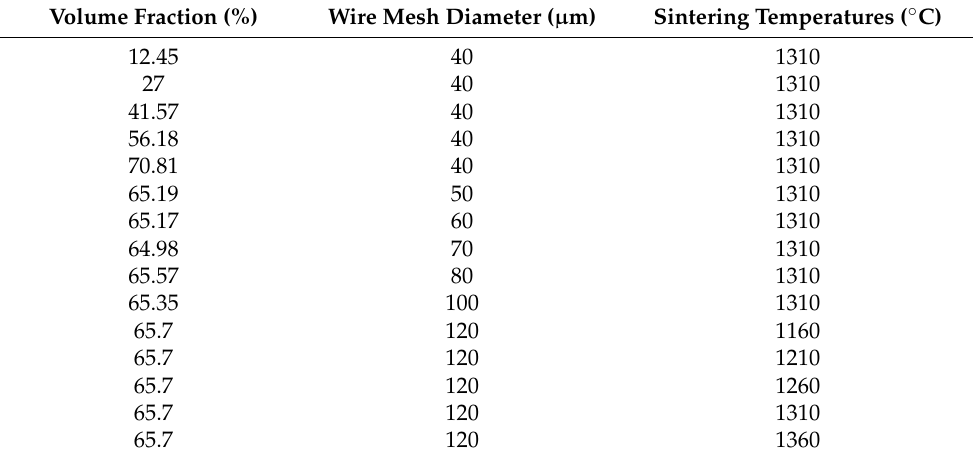
Table 1. PWMCPPs with different processing